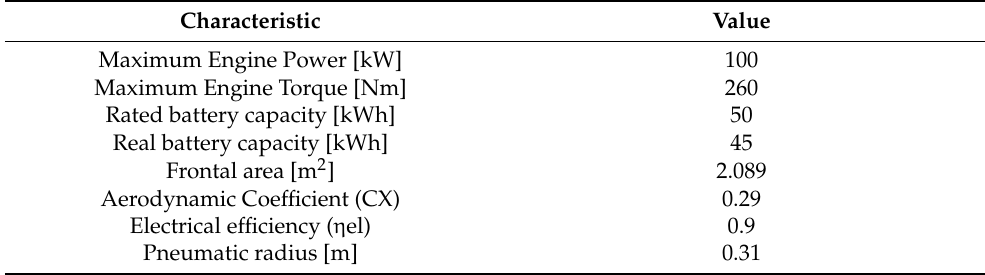
Table 6. Characteristics of the chosen